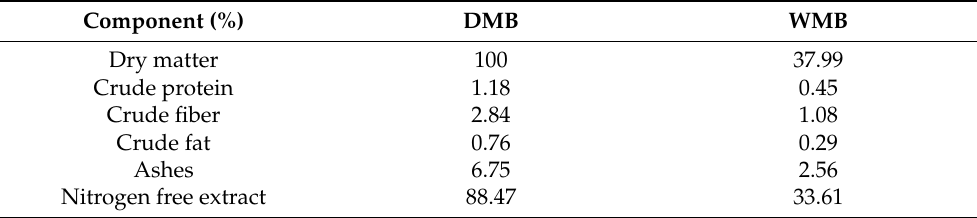
Table 1. OrP ( Opuntia robusta pulp) bromatological analysis.